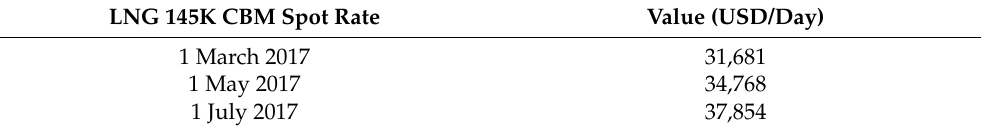
Table 2. Real values for the time series LNG 145K CBM spot rate for the prediction dates.